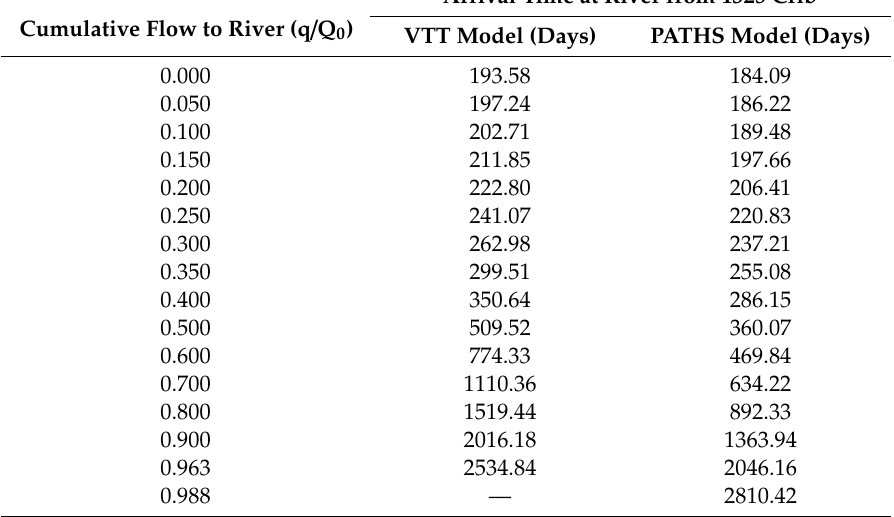
Table 1. Comparison of results for contaminated water from the 1325 Crib travel time to the river for the VTT (heterogeneous model and representation) and PATHS (bounding homogenous model and